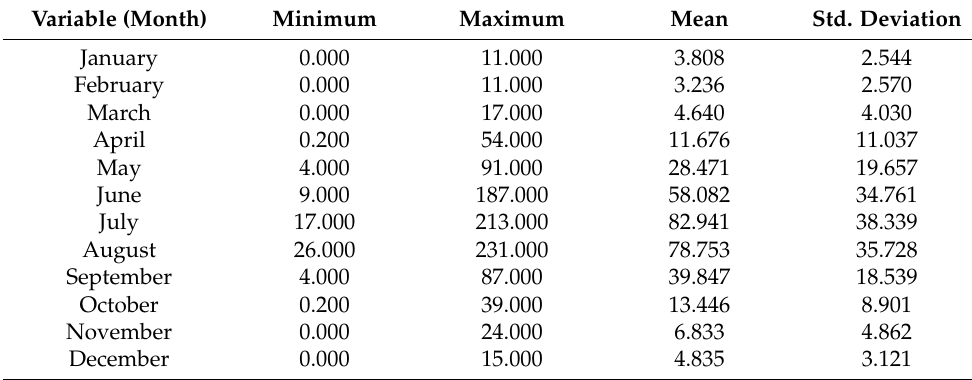
Table 1. Basic statistical characteristics of the Kyakhta rainfall data.